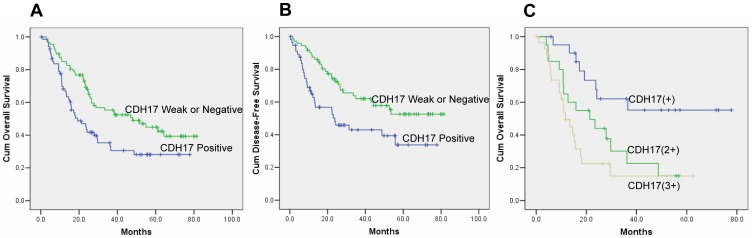
Relationship between CDH17 expression and outcome of patients with gastric cancer.Kaplan-Meier survival analysis with different CDH17 expression. A. Overall survival in 156 patients with gastric carcinoma (p<0.01) B. Disease-Free Survival in 131 gastric carcinoma patients who underwent R0 resection (p<0.01). C. Overall survival in 156 patients with gastric carcinoma according to CDH17 status (IHC 1+, 2+ and 3+)(p<0.01).